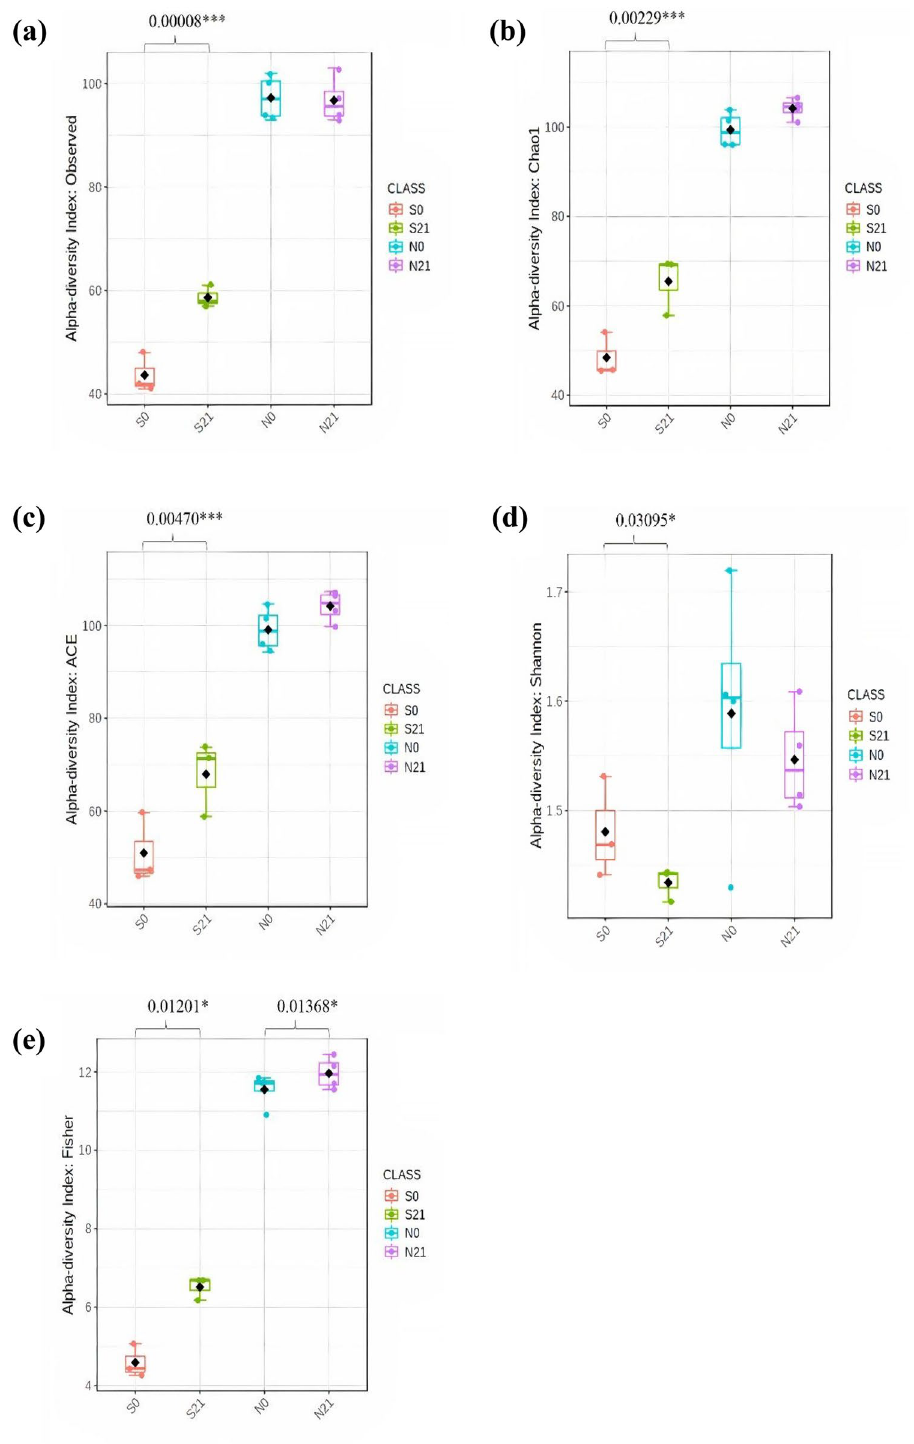
Figure 3. Alpha diversity of bacterial communities before and after ensiling for sweet corn and Napier: (a) observed OTU (F-value: 162.3; p- value = 0.00001), (b) Chao1 (F-value: 125.38; p- value = 0.00001), (c) ACE (F-value: 64.905; p- value = 0.00001), (d) Fisher (F-value: 291.78; p- value = 0.00001), (e) Shannon (F-value: 1.4881; p- value = 0.27669) indices measured at feature level (S0, Fresh sweet corn; S21, Sweet corn silage; N0, Fresh Napier; N21, Napier